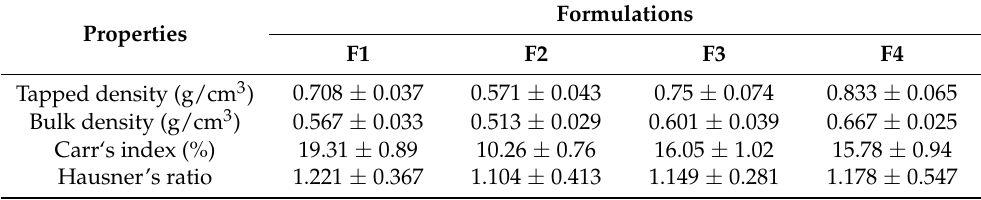
Table 2. The physical properties of meloxicam granules of formulations F1, F2, F3 and F4.